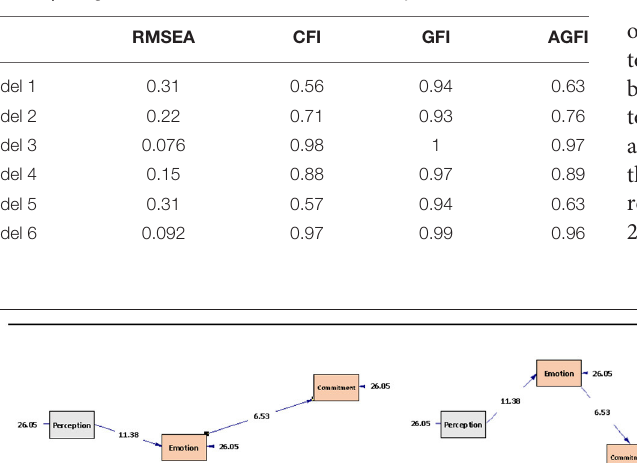
TABLE 3 | The goodness of fit statistics for the Path Analysis.